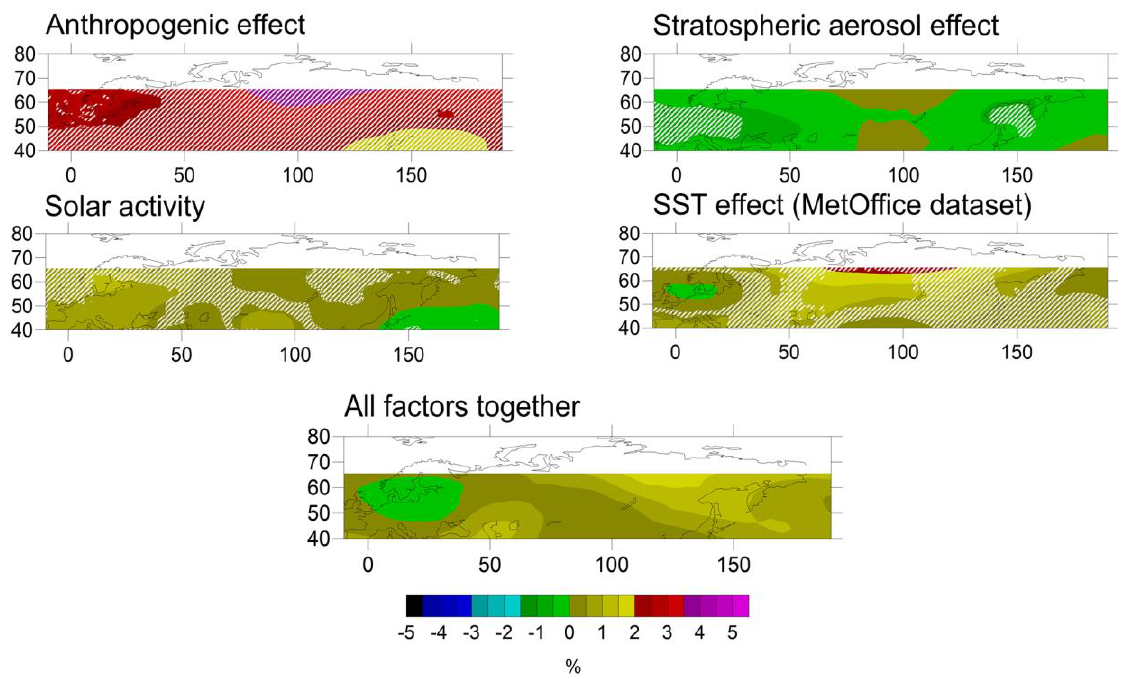
Figure 5. Difference in the average of annual Eery anomalies for the period 2000–2015 and the period 1979–1999, due to changes in total ozone column according to effects of different anthropogenic and natural factors. INM-RSHU CCM simulations. Statistically significant difference at p = 95% are shown by white hatching. X-axis—is longitude, Y-axis—is latitude.